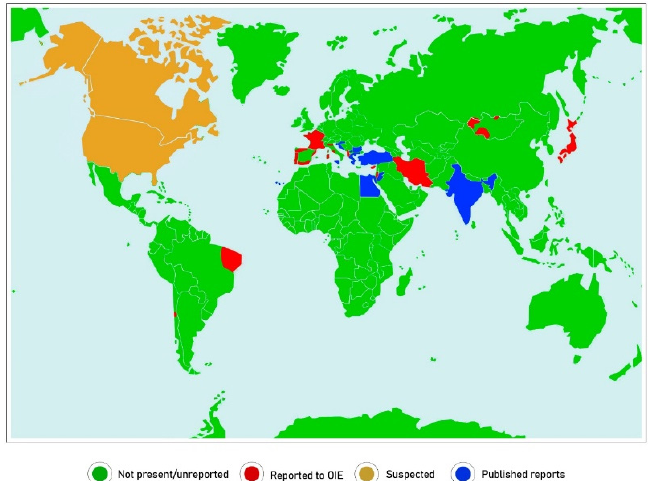
Figure 1. Countries reporting the mycoplasmas causing contagious agalactia worldwide.